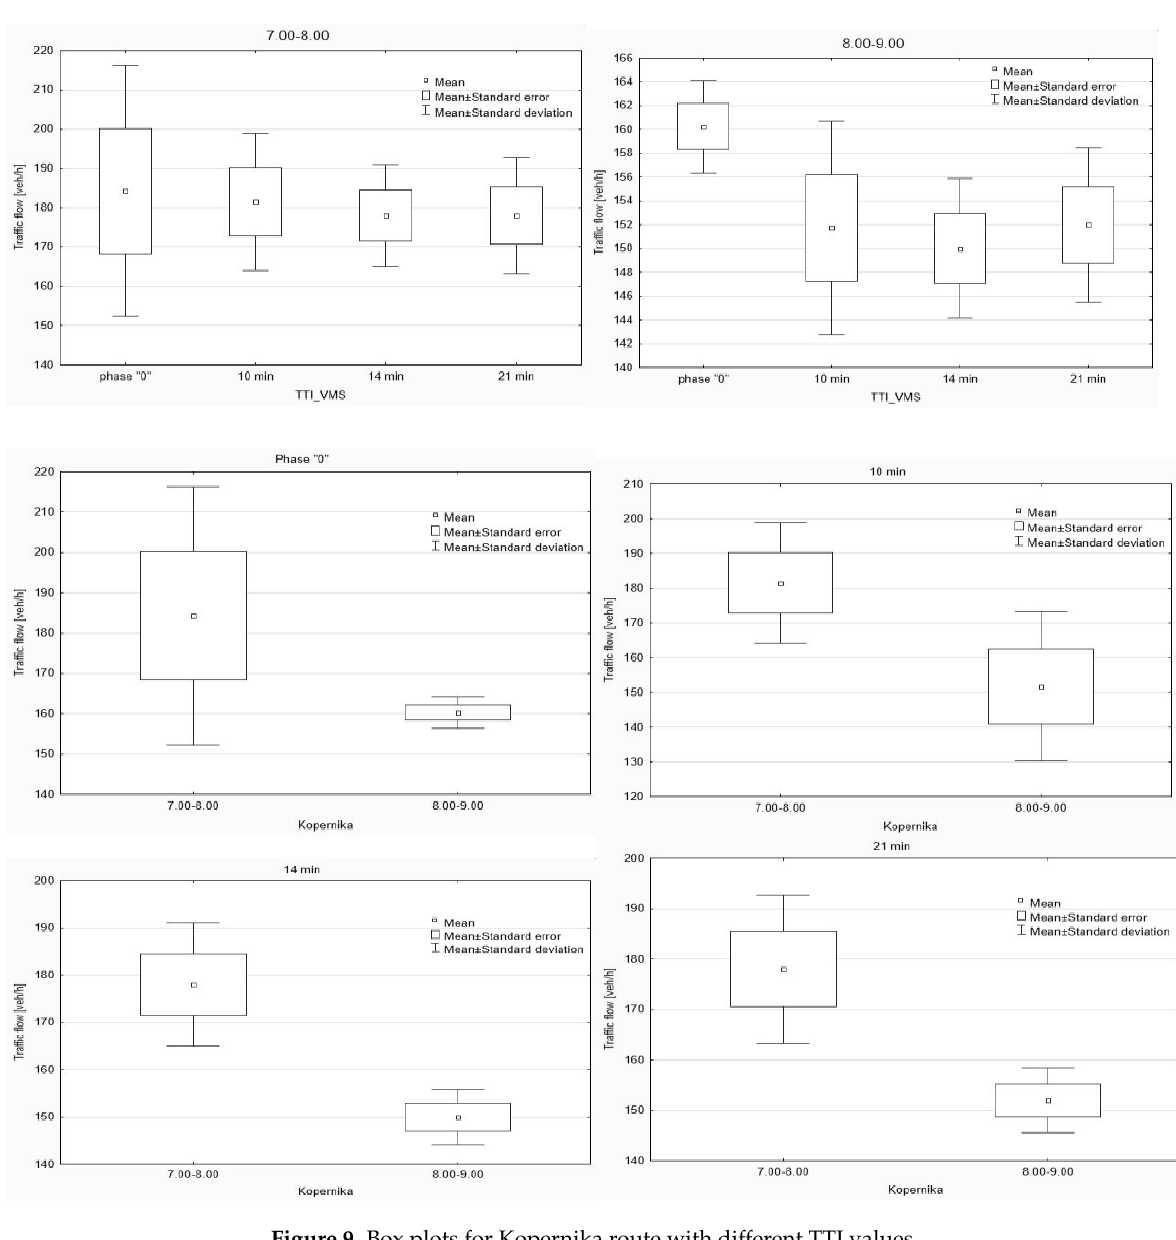
Figure 9. Box plots for Kopernika route with different TTI values.